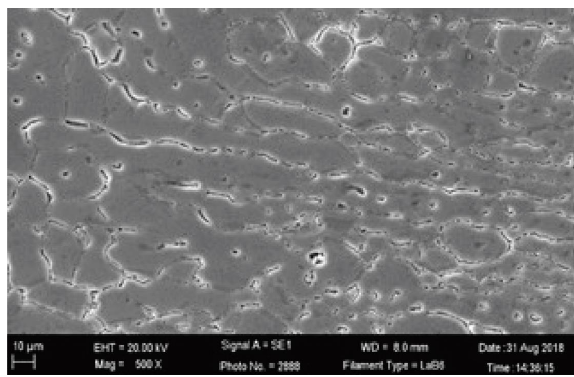
Figure 5: SEM micrograph of the weldment fabricated at